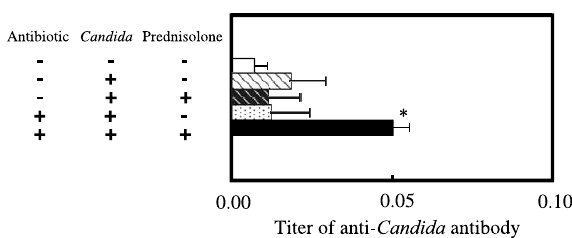
FIG. 4. Enhanced production of anti-Candida antibody (IgE) in sera of C. albicans-infected mice treated with predniso- lone. Serum levels of antibodies were tested 4 weeks after the Candidainfections. Specific IgE of anti-Candidaantibody was measured using a specific ELISA as described in Materials and methods. Each value represents the mean 9 / standard error of five mice per group. *p B / 0.05, when compared with the control (normal mouse